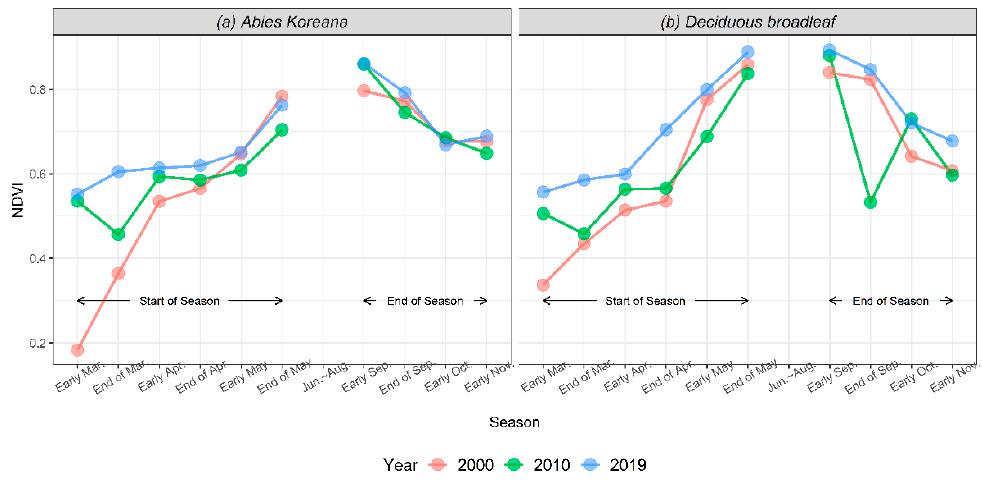
Figure 5. Time-series of phenological change in ( a ) Abies koreana and ( b ) deciduous broadleaf forest from March to November (excluding June–August).